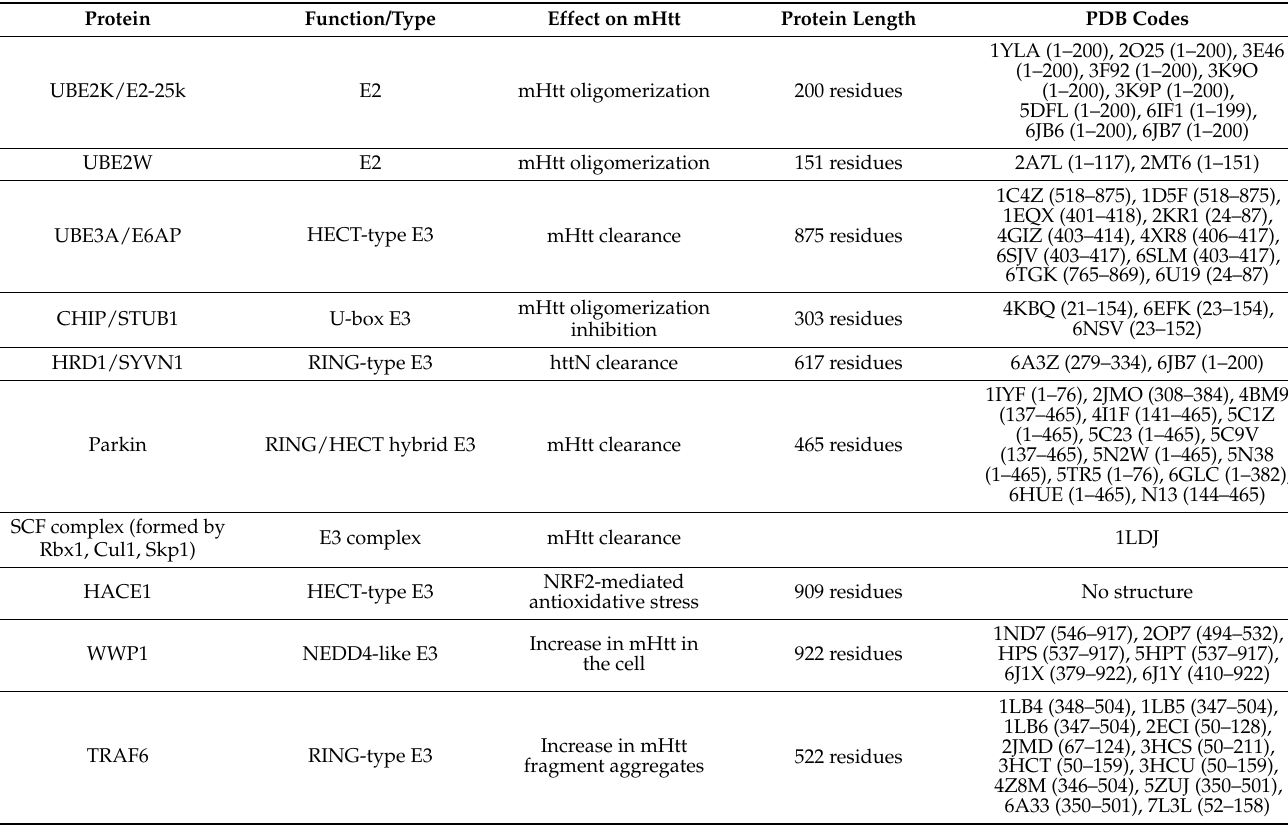
Table 2. Ubiquitin–proteasome system enzymes involved in mHtt and Htt ubiquitination and